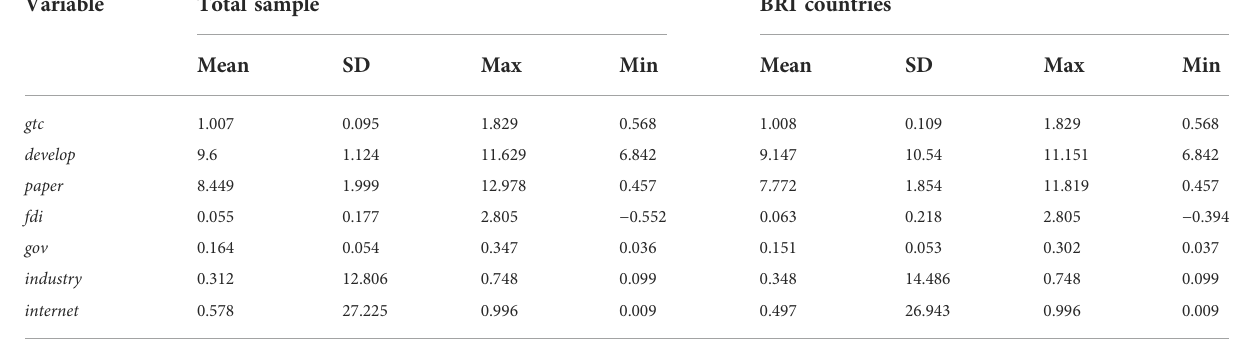
TABLE 1 Sample statistical results of each variable.